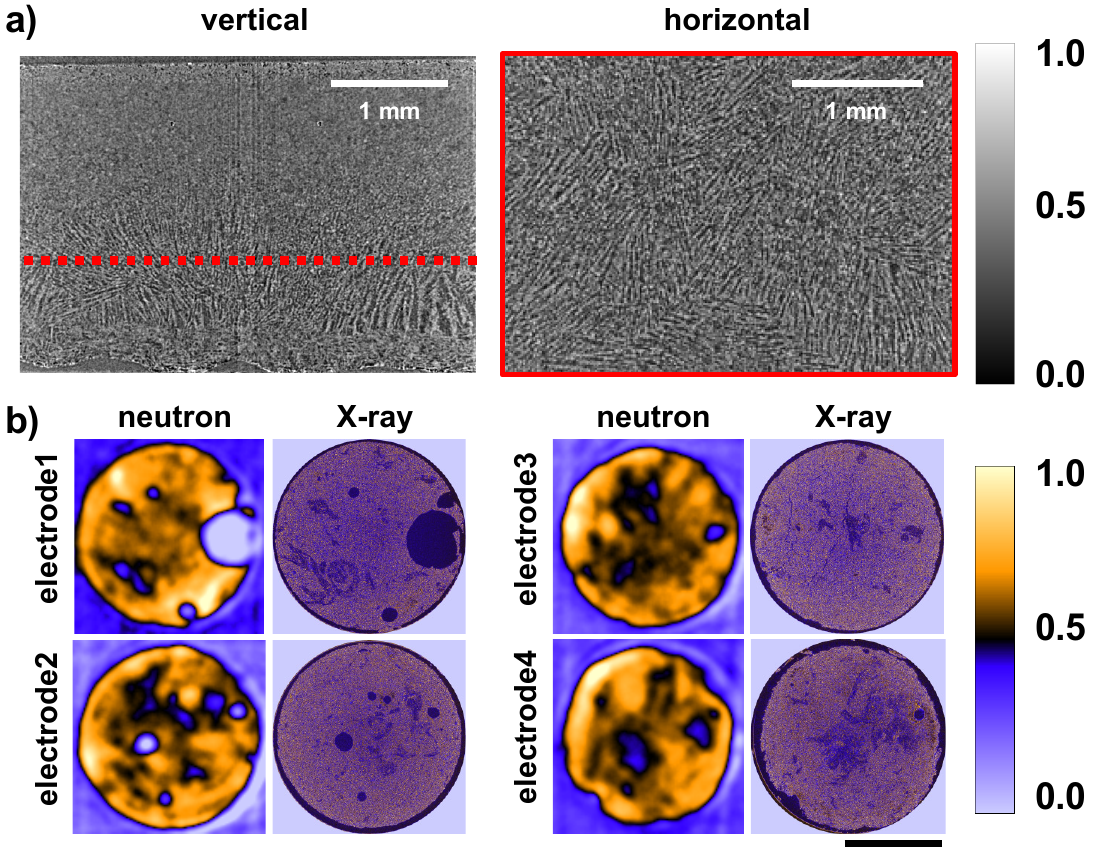
Figure 2. Orthogonal slices of the reconstructed X-ray tomogram of the 12 mm diameter DIT graphite electrode and comparison with the polychromatic neutron and X-ray attenuation of the lithiated DIT graphite electrodes. ( a ) Vertical and horizontal slices of the 12 mm graphite electrode showing the coral-like pore structure with larger radii and longer branches in the lower electrode section in the vertical slice. ( b ) Horizontal slices of the four 6 mm diameter electrodes, indicating (for the neutron data) the attenuation-based distribution of the graphite, LiC 12 and LiC 6 phases. Low attenuating regions are bright blue and blue; higher attenuating regions are yellow. For comparison, the X-ray images show the graphite density distribution at the same electrode height.